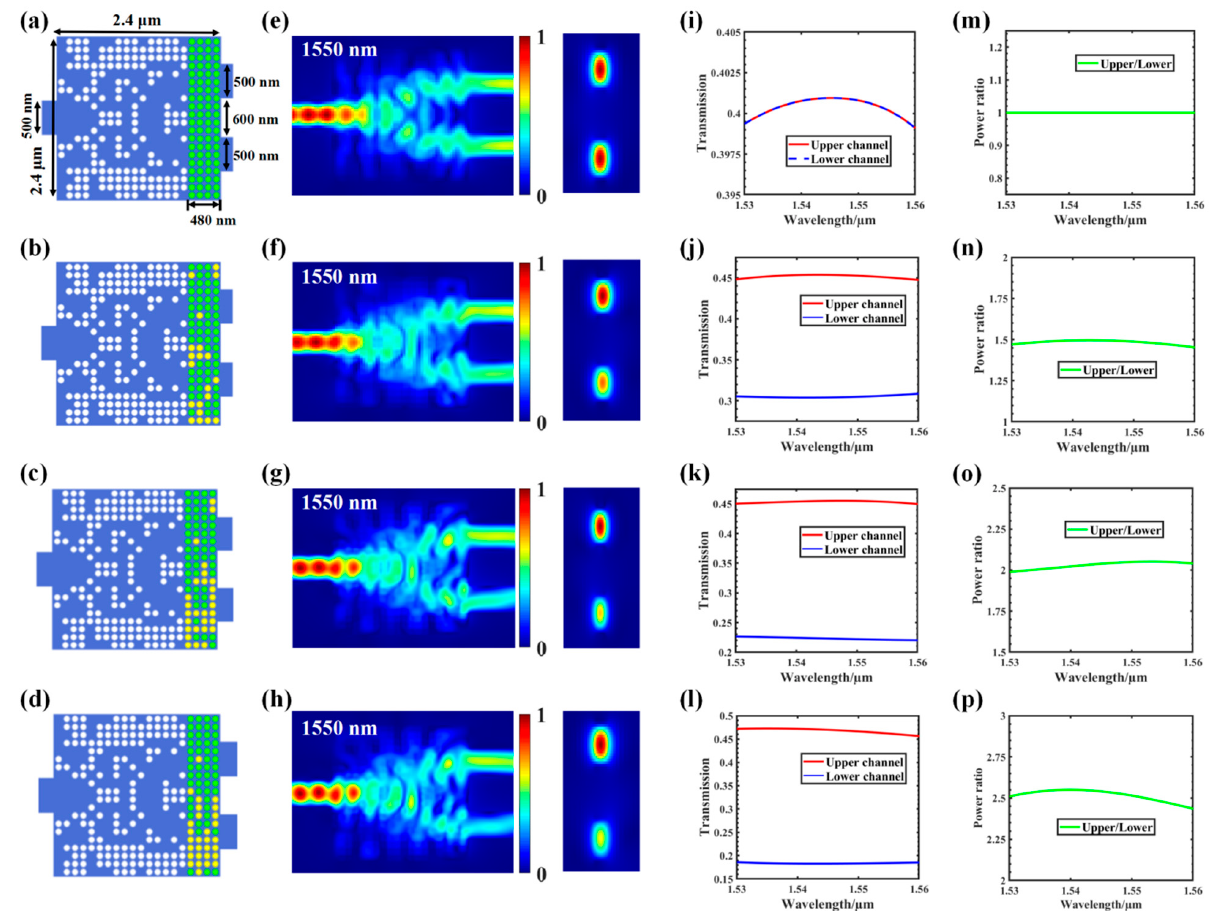
Figure 5. Extension to other power splitting ratios: ( a – d ) structure diagram of the 1 × 2 power splitter with 1:1, 1.5:1, 2:1, and 2.5:1 split ratios; ( e – h ) light field distribution at 1550 nm of the upper and lower channels; ( i – l ) transmission spectra of all tested channels; ( m – p ) simulated power–split ratio for the 1 × 2 splitter, where the green line indicates the simulated power ratio between the upper and lower channels in the wavelength range of 1530–1560 nm.